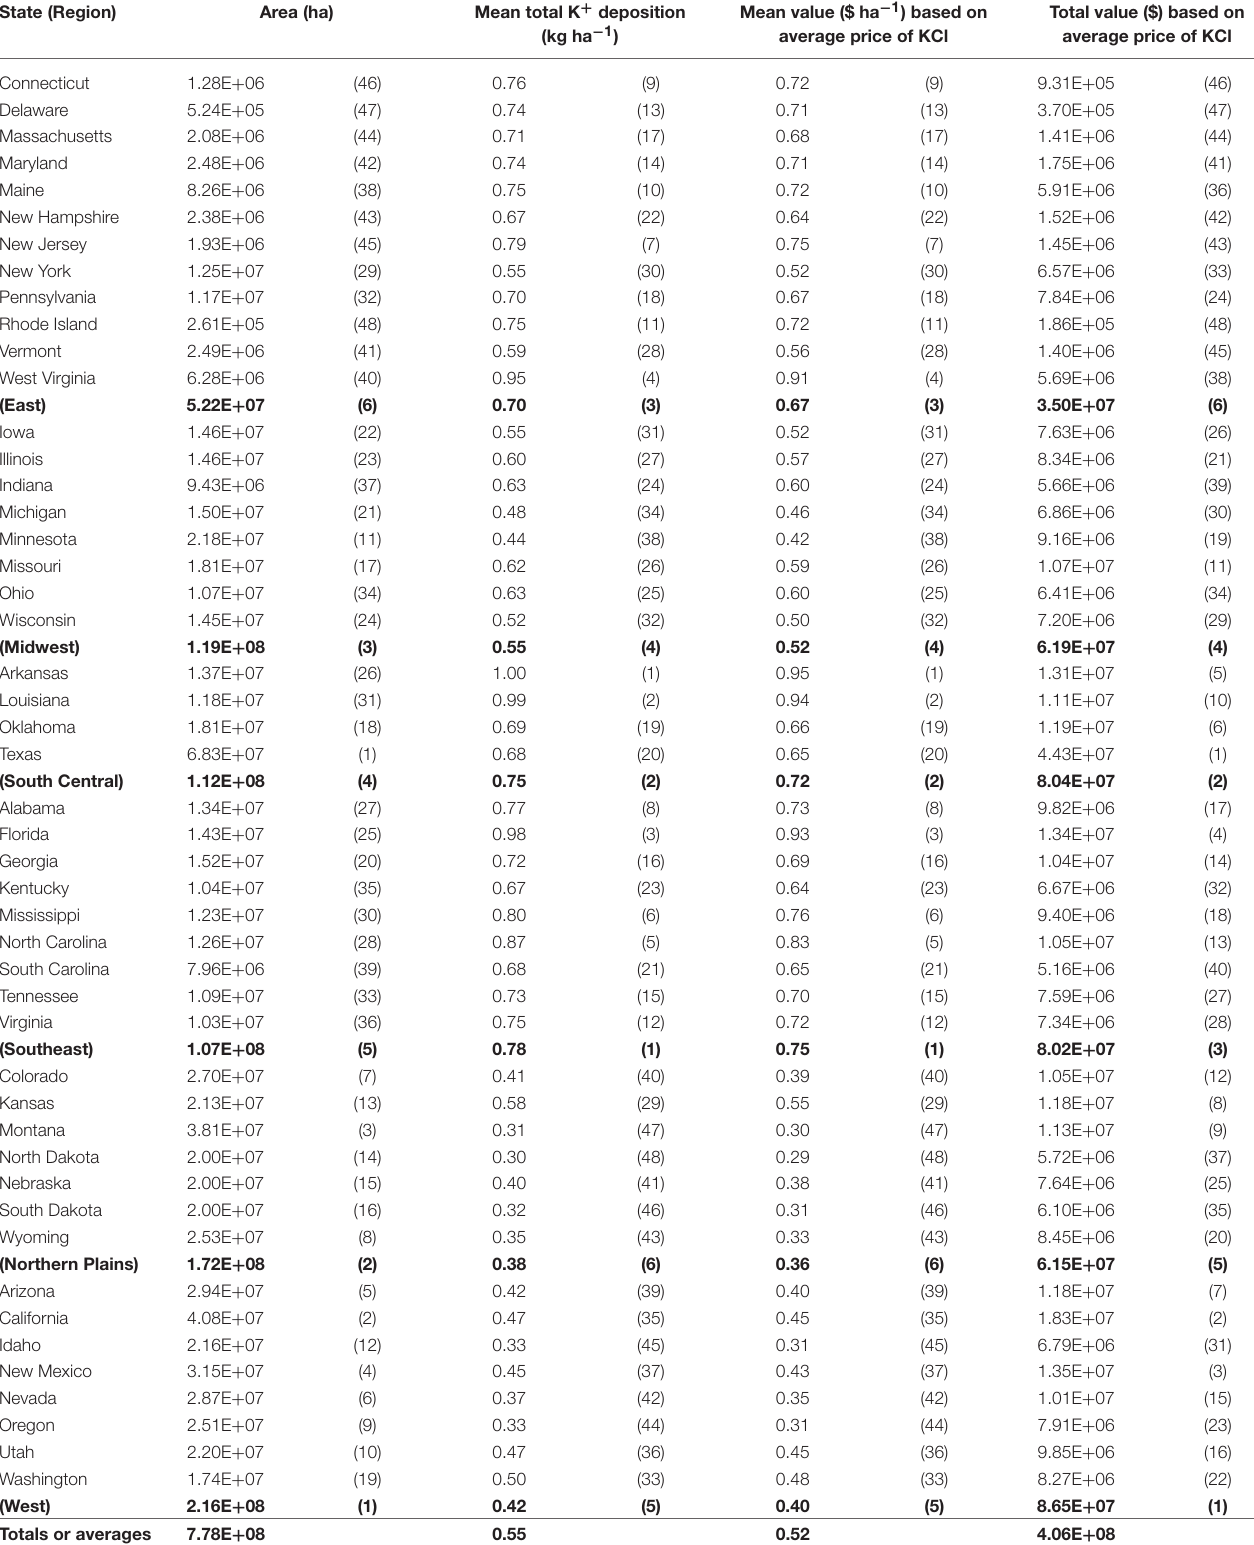
Bold type indicates regions consisting of the states listed immediately